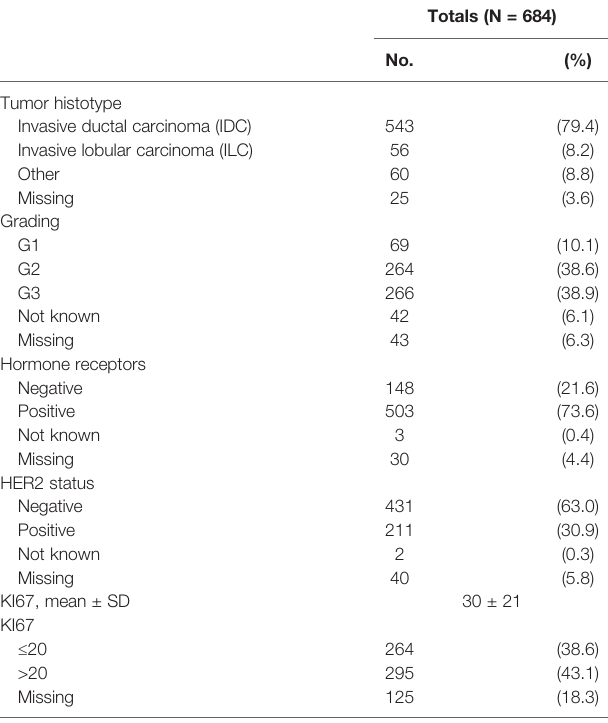
TABLE 2 | Histopathological features of breast cancer